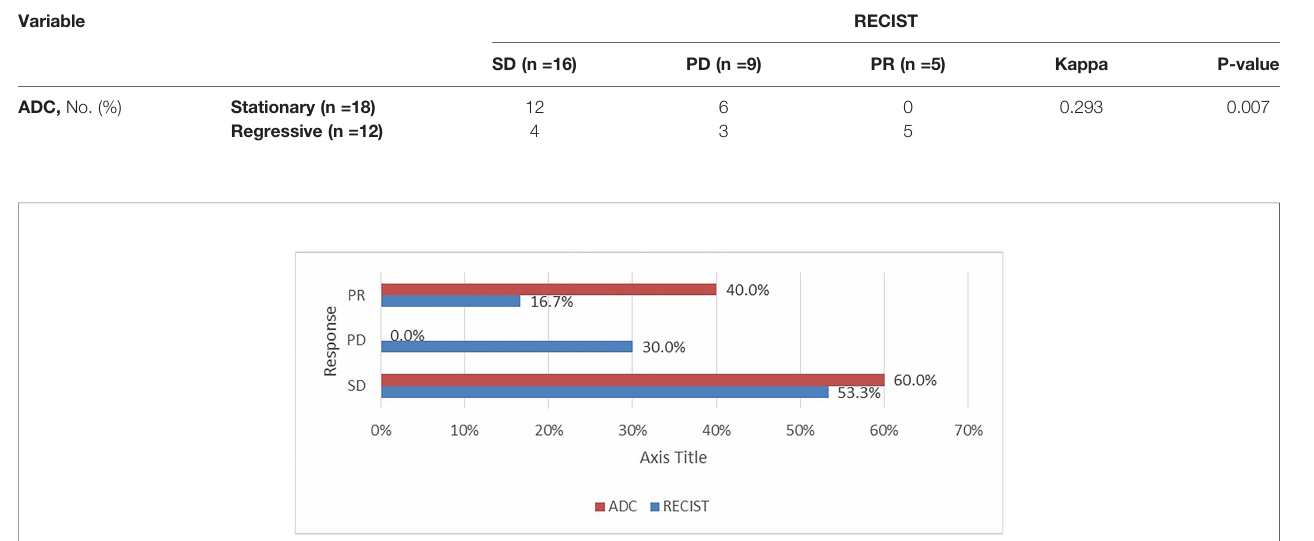
TABLE 3 | Association between ADC response and RECIST.